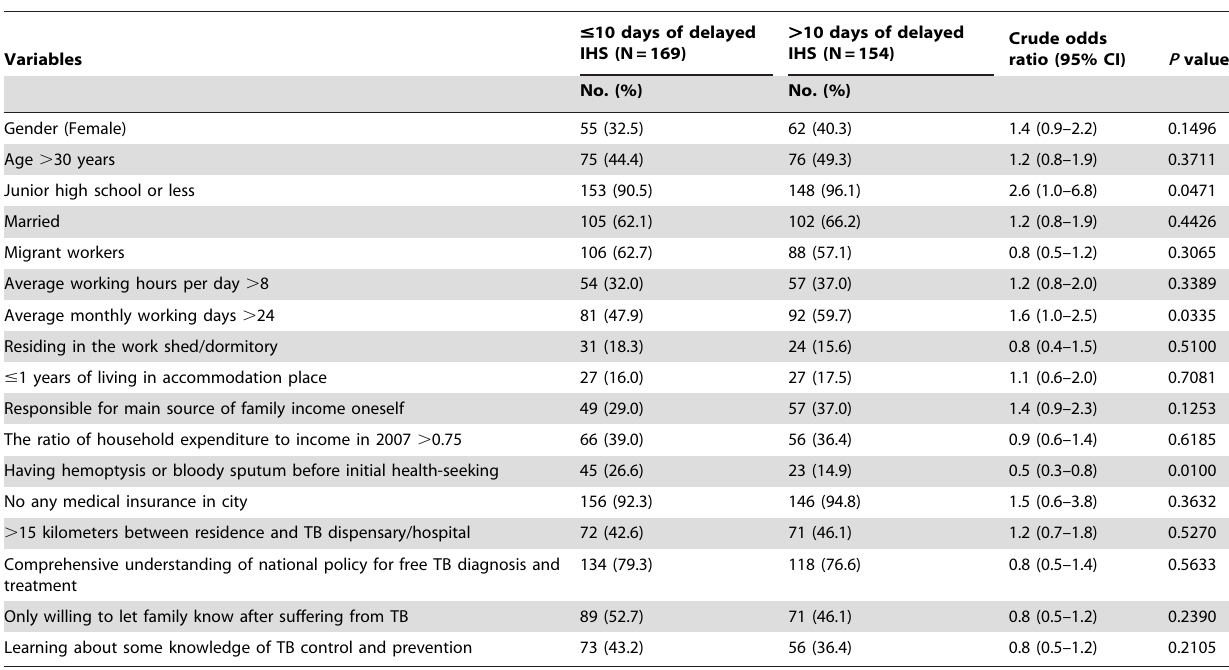
Table 2. Univariate analysis of characteristics of new PTB cases among the migrant population and their association with delayed initial health-seeking